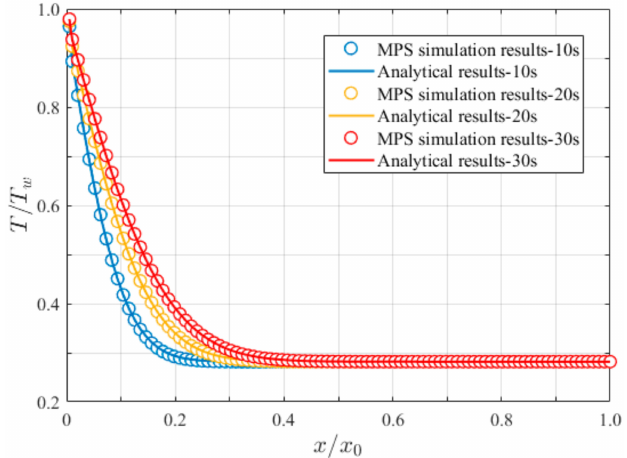
Figure 8. Comparison of the temperature distribution between numerical simulations and the analytical